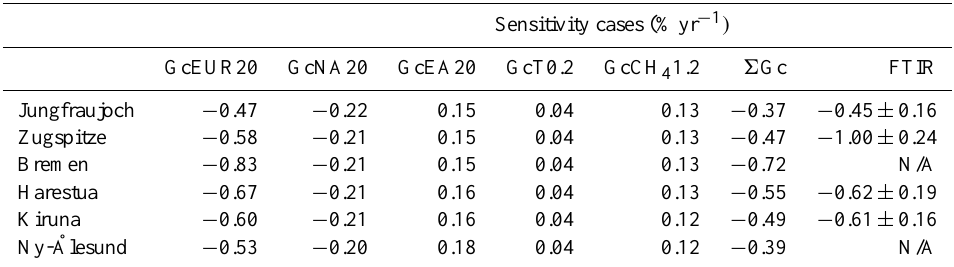
Table 8. Change in the CO partial column per year through the 1996–2006 time period. All the simulations are done on year 2006 and are scaled to represent the yearly change. No FTIR trends are estimated for Bremen and Ny- ˚Alesund due to the short time series and lack of winter measurements.